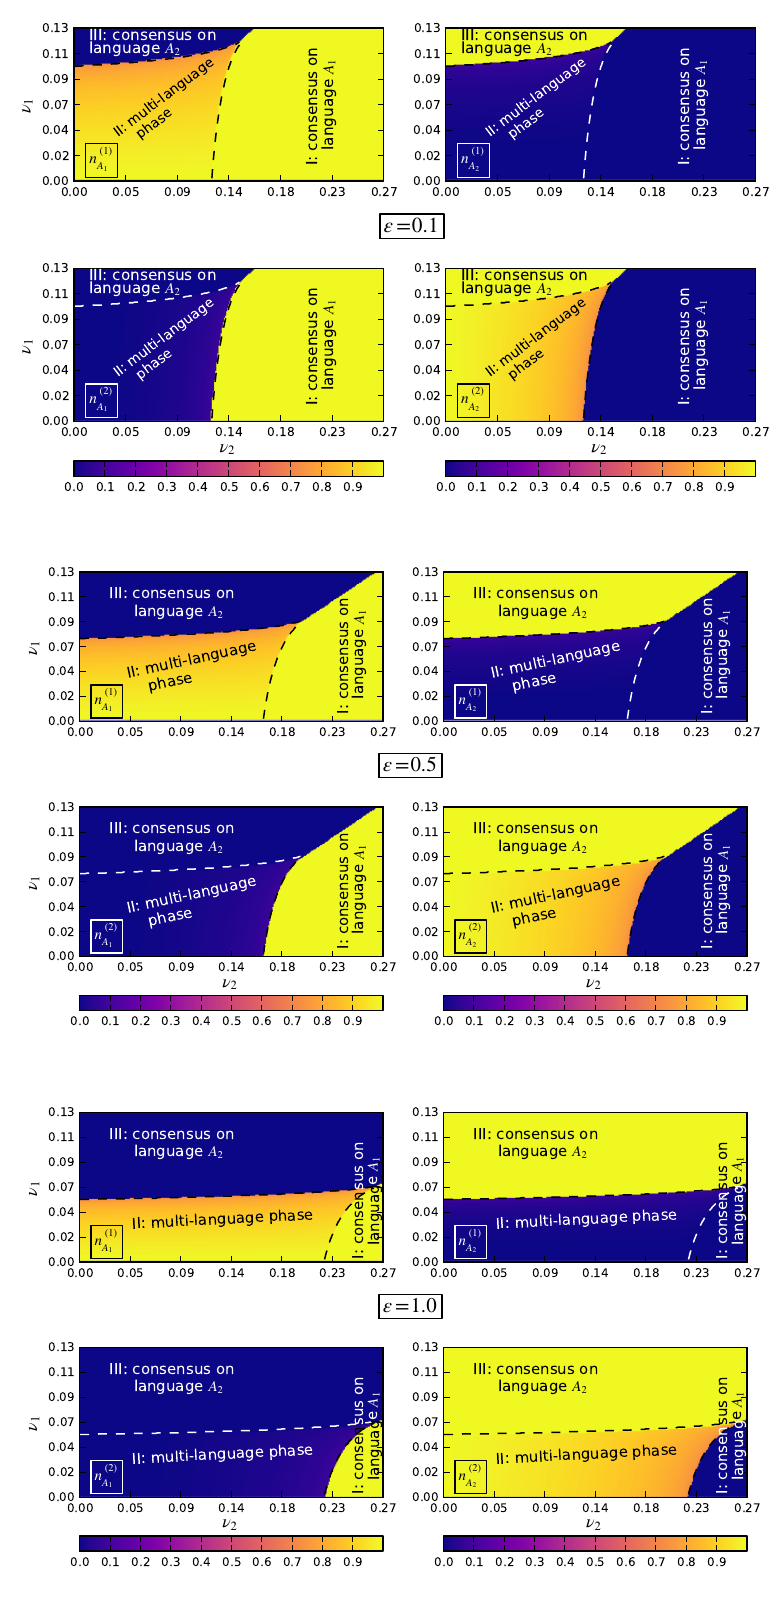
Figure 11. Phase diagram of the NG in the Stochastic Block Model (SBM) with Q = 2 and N ( 2 ) = ( 1 + (cid:101) ) N ( 1 ) for (cid:101) =